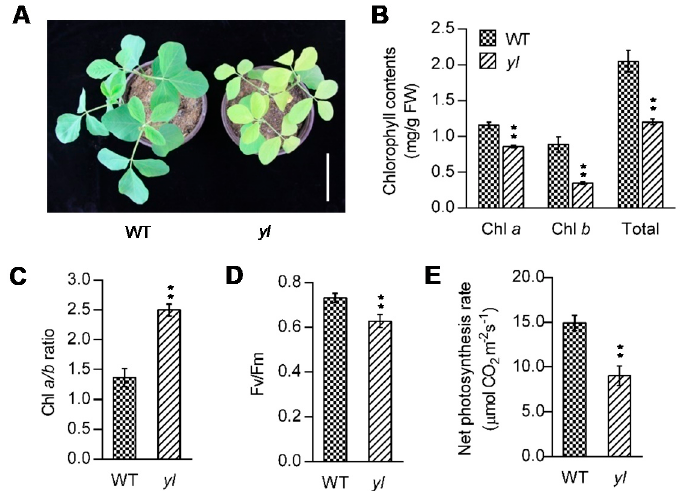
Figure 1. Phenotypic characterization of the wild type and yl mutant plants. ( A ) Two-week-old wild type (left) and yl (right) seedlings. ( B ) Chlorophyll contents of the third leaf of the wild type (left) and yl (right) plants. ( C ) The Chl a / b ratio of the wild type (left) and yl (right) leaves. ( D ) The maximum photochemical efficiency of PSII measured by the Fv/Fm chlorophyll fluorescence ratio in the wild type (left) and yl (right) leaves. ( E ) The net photosynthesis rate of the wild type (left) and yl (right)